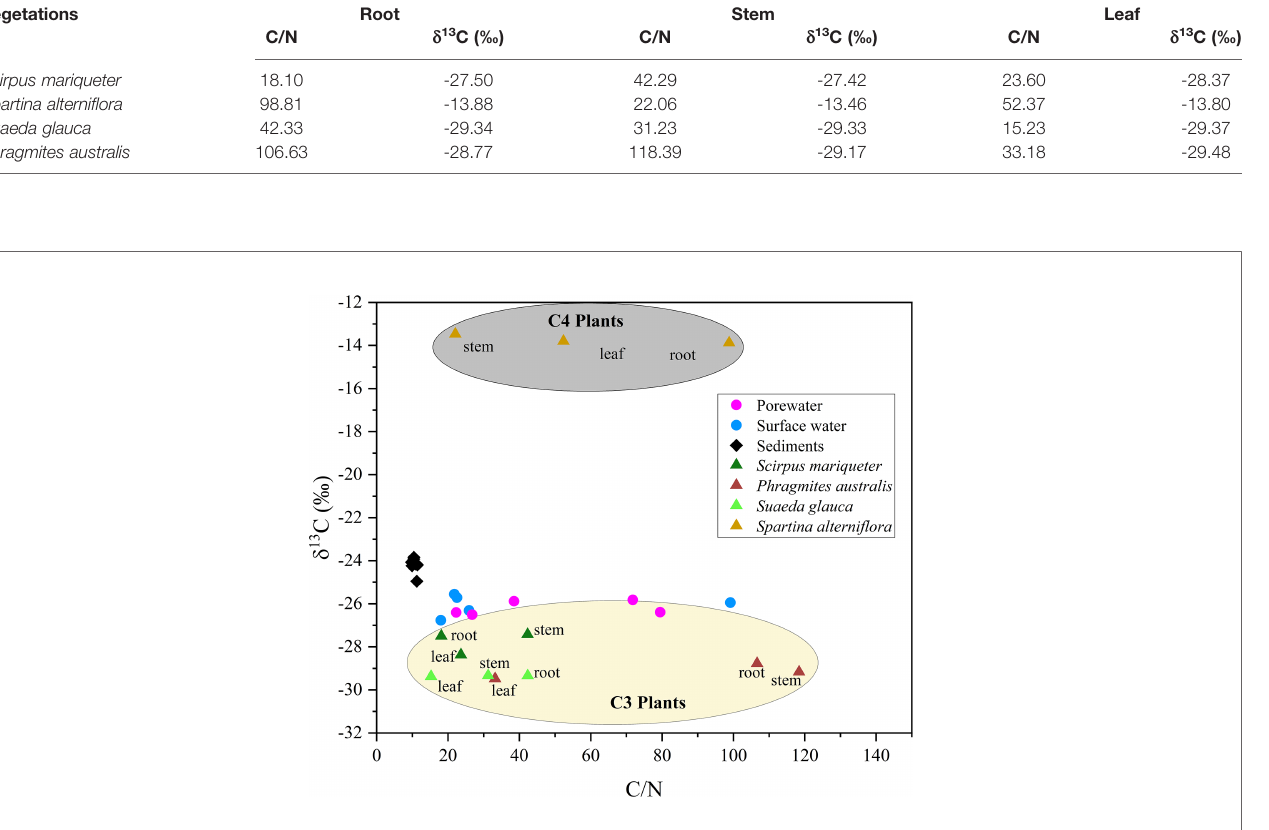
FIGURE 5 | Stable carbon isotope of organic carbon in surface water, porewater, sediment and vegetations (including Scirpus mariqueter , Spartina alterni fl ora , Suaeda glauca and Phragmites australis ), and corresponding C/N molar